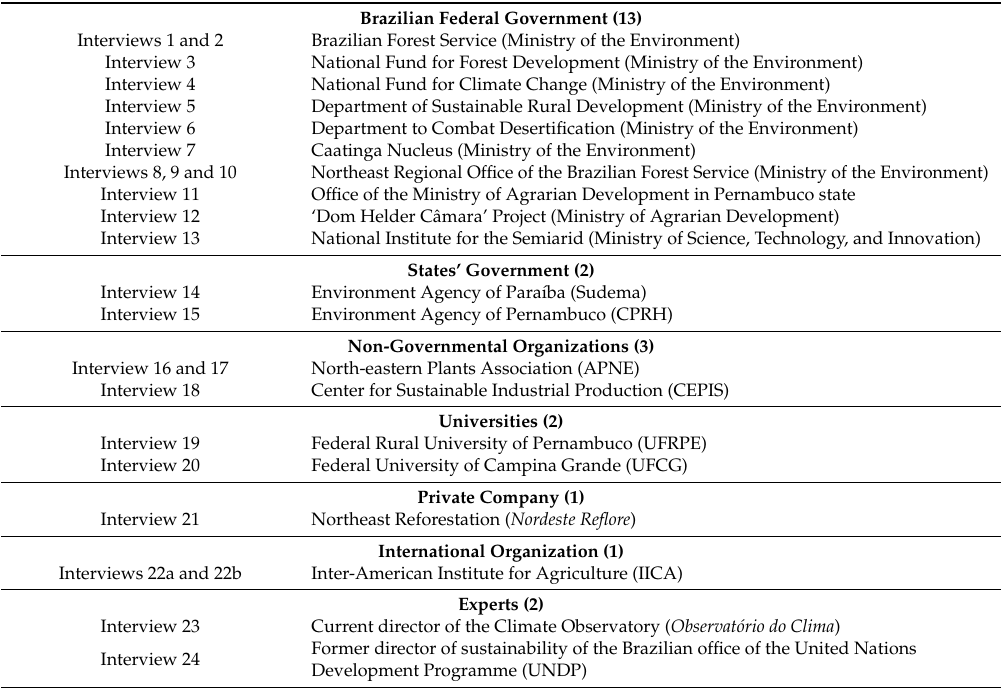
Table 1. List and profile of